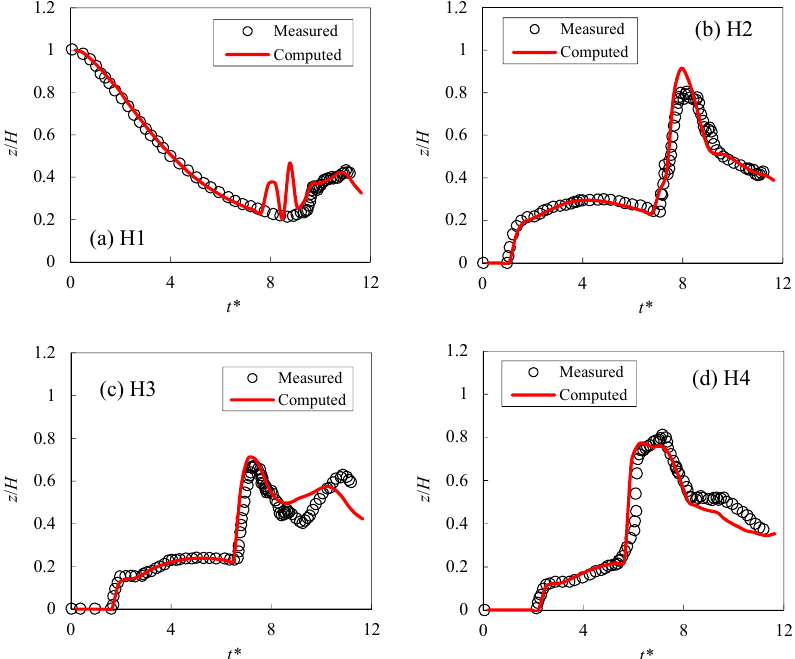
Figure A1. Sketch of experimental setup in the literature of Lobovský et al. (2014).